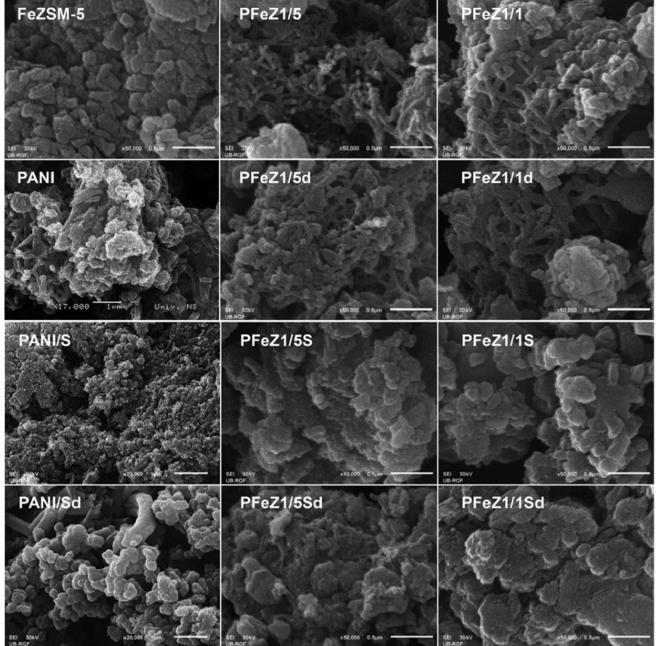
Figure 18. SEM images of PANI, FeZSM-5, and their composites. Reprinted with permission from Ref. [33]. Copyright 2018 Elsevier.